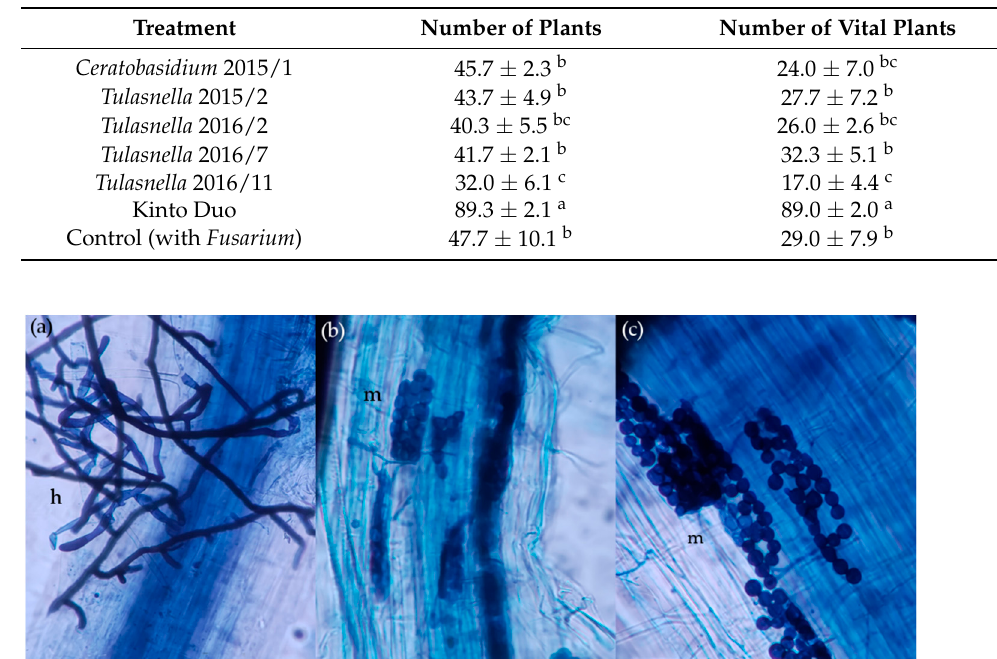
Table 3. Percentage of wheat root colonization in all pot experiments and barley root colonization in field conditions, after inoculation with varia fungi isolates (Figure 3). Data are expressed as means ± SD ( n = 3) followed by the same letter (within the column) if there was no statistical difference according to LSD 0.05 test. ND—not detected. Table 2. Significant evaluated parameters of Experiment 1 include numbers of plants emerged from 100 grains contaminated with Fusarium culmorum (tribe KM16902) sown, and numbers of vital plants lacking any symptoms of necrosis or chlorosis caused by F. culmorum . Data represent means ± SD ( n = 3) followed by the same letter (within the column) if there was no statistical difference according to LSD 0.05 test.